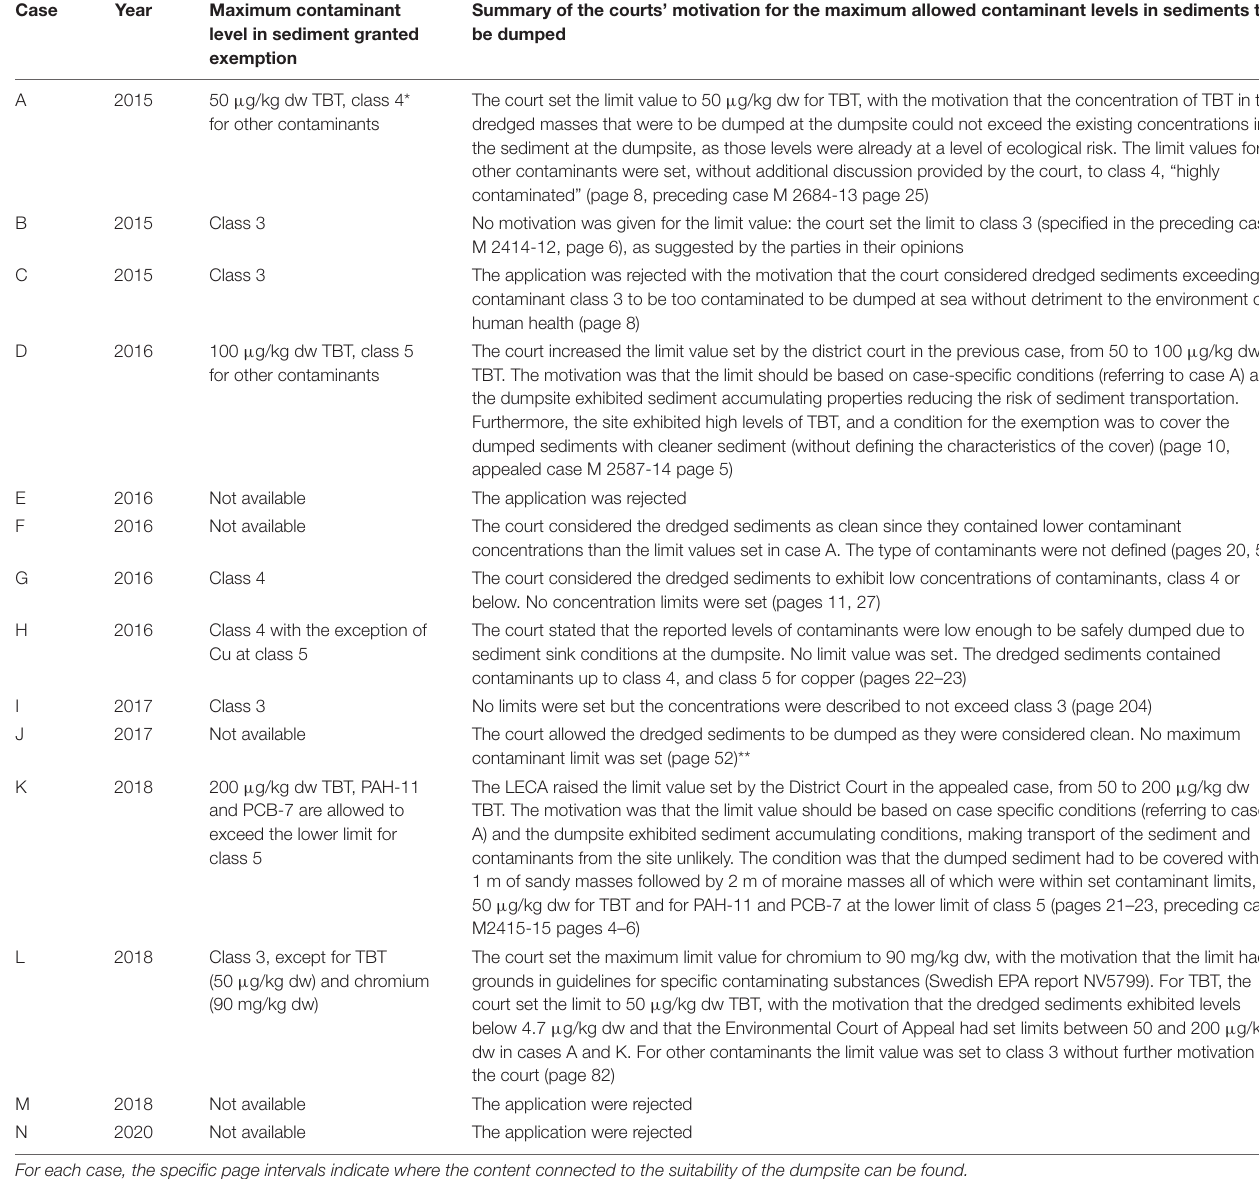
TABLE 3 | Maximum contaminant level accepted for dumping with summaries of reasoning by the courts when determining whether the dredged sediments were safe to dump without risk of environmental detriment.